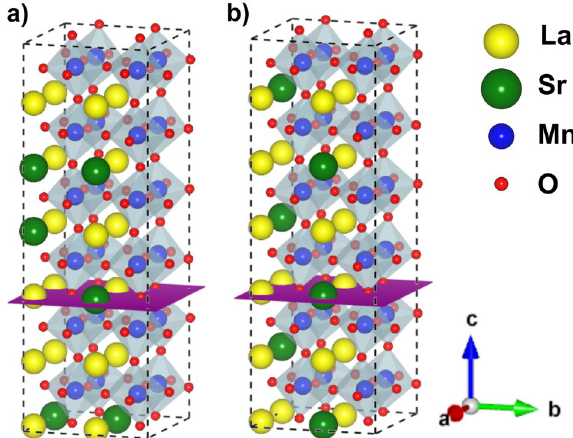
Figure 3. LSMO pseudocubic 2 × 2 × 6 supercells employed. ( a ) x = 0.25 and random doping, ( b ) x = 0.25 and ordered doping. Medium size blue spheres represent Mn atoms, little red spheres are O atoms, big yellow spheres are La atoms and bigger green spheres, Sr atoms. The violet shaded area indicates the ab-plane where the oxygen vacancy is placed. Structures visualized with VESTA 19